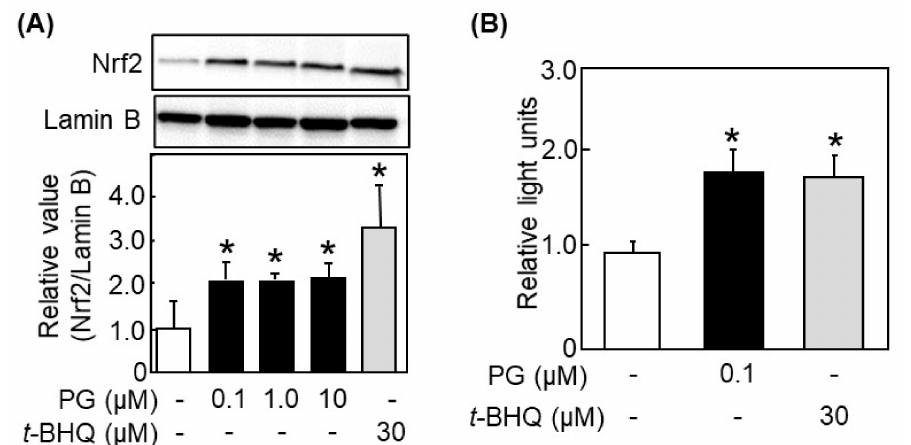
Figure 4. Nuclear accumulation of Nrf2 and ARE-mediated transcriptional activity in PG-treated HepG2 cells. ( A ) Nuclear accumulation of Nrf2 after treatment with PG to HepG2 cells was de- termined by western blotting. Th upper panel shows typical blot data, while the bottom one is the intensity of specific bands after normalizing data by the Lamin B level. ( B ) Effect of PG on ARE-mediated transcriptional activity was evaluated by Luciferase reporter assay as described in the Section 2.10. Values are the mean ± SE ( n = 3), * p < 0.05 vs. control by Dunnett’s multiple comparison test.